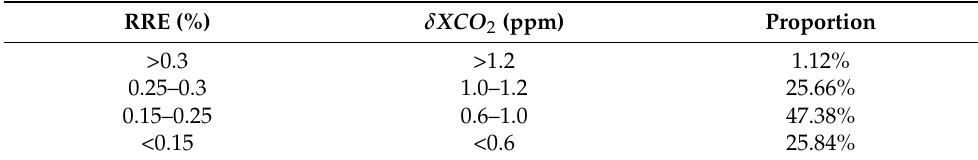
Figure 18. ( a ) Global SNR calculated by using MODIS data and CALIPSO data from 2018 and Equation (8). ( b ) The corresponding global RRE. Table 3. Proportion of RRE or different segments.